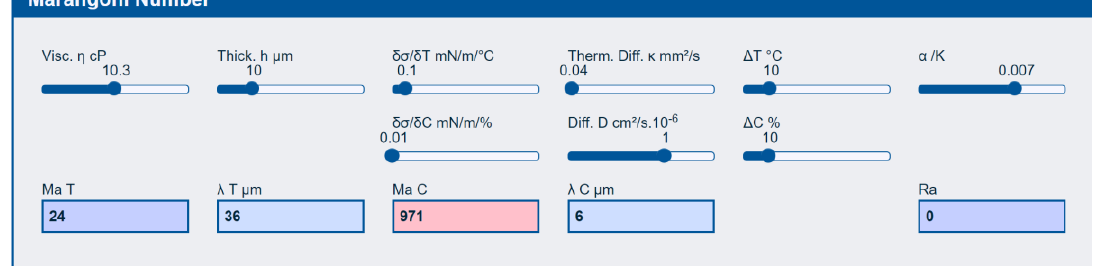
Figure 6. If a coating exceeds the critical Marangoni number (≈80), it is likely to show orange-peel defects. In this example, the thermal Marangoni number (Ma T) is only 24, so there is no problem. However, the concentration number, Ma C is very large, so defects are likely. The app is at www.stevenabbott.co.uk/practical-coatings/Marangoni.php.